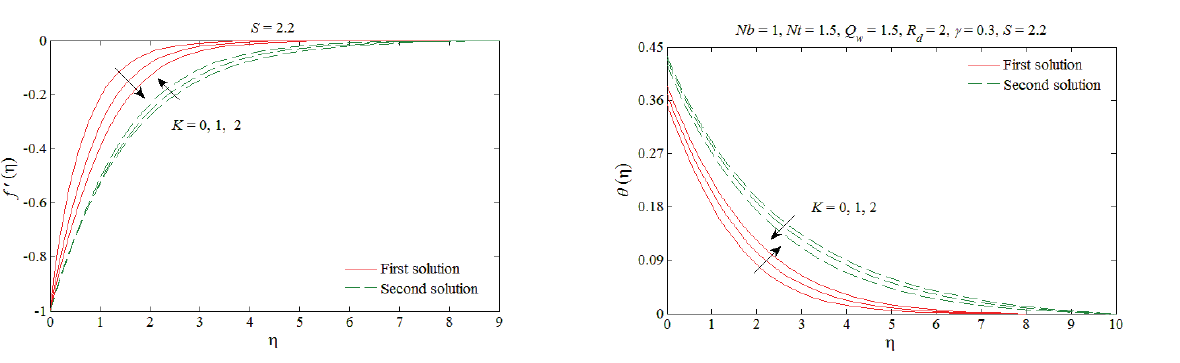
Fig. 1: The velocity profiles for different values of K . Fig. 2: The temperature profiles for different values of K .